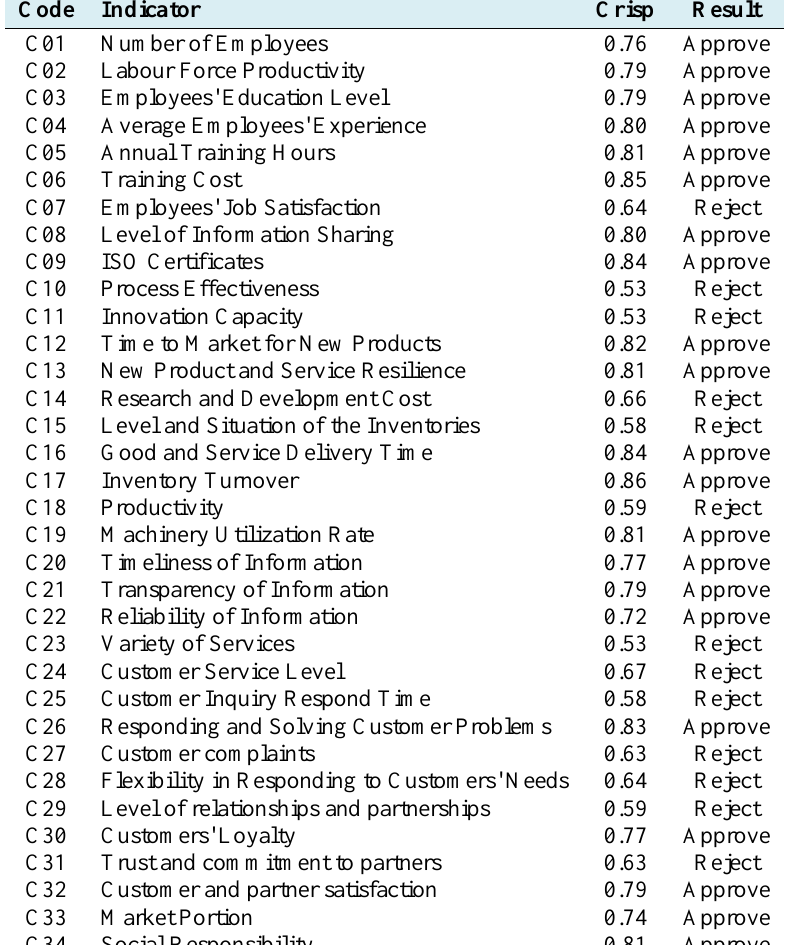
Table 7. Results of screening of research